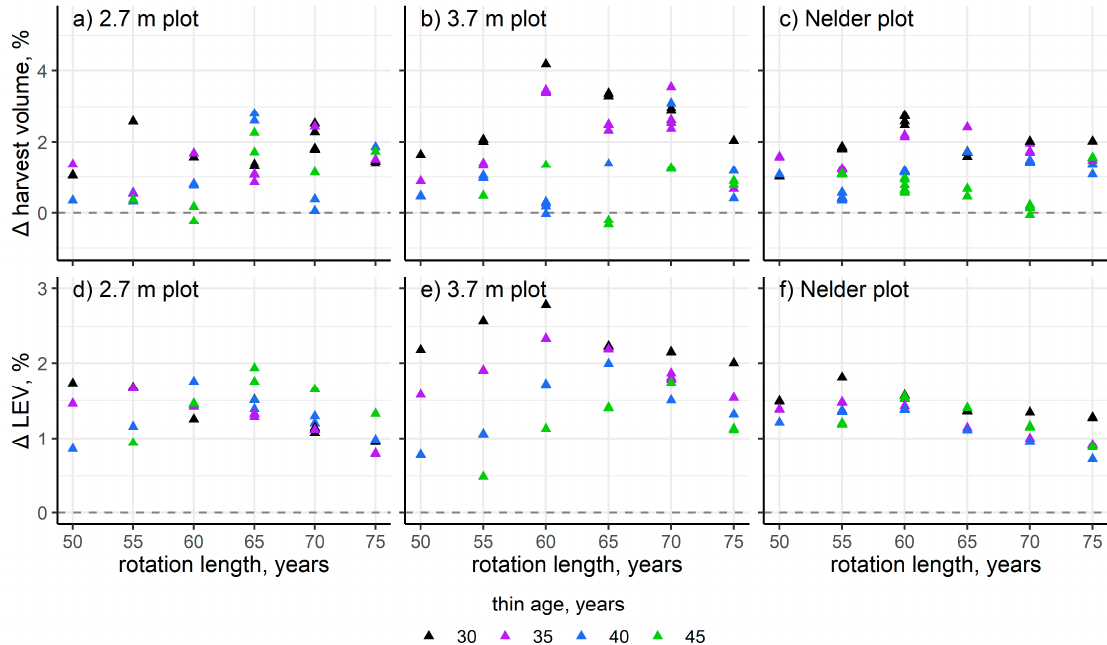
Figure 4. Changes in total merchantable volume harvested (thinned plus final harvest) and increases in LEV over optimized conventional prescriptions due to use of heuristic tree selection by plot, rotation length, and thinning age. Correlations between harvest volume and LEV were 0.08, 0.71, and 0.08 for the 2.7 m, 3.7 m, and Nelder plots, respectively. Table 5. Changes in merchantable volume harvested and increases of median LEVs relative to the reference prescription from use of heuristic tree selection on the 2.7 and 3.7 m plots. The reference prescription was not valid for the Nelder plot, other rotation lengths, or other thinning ages.